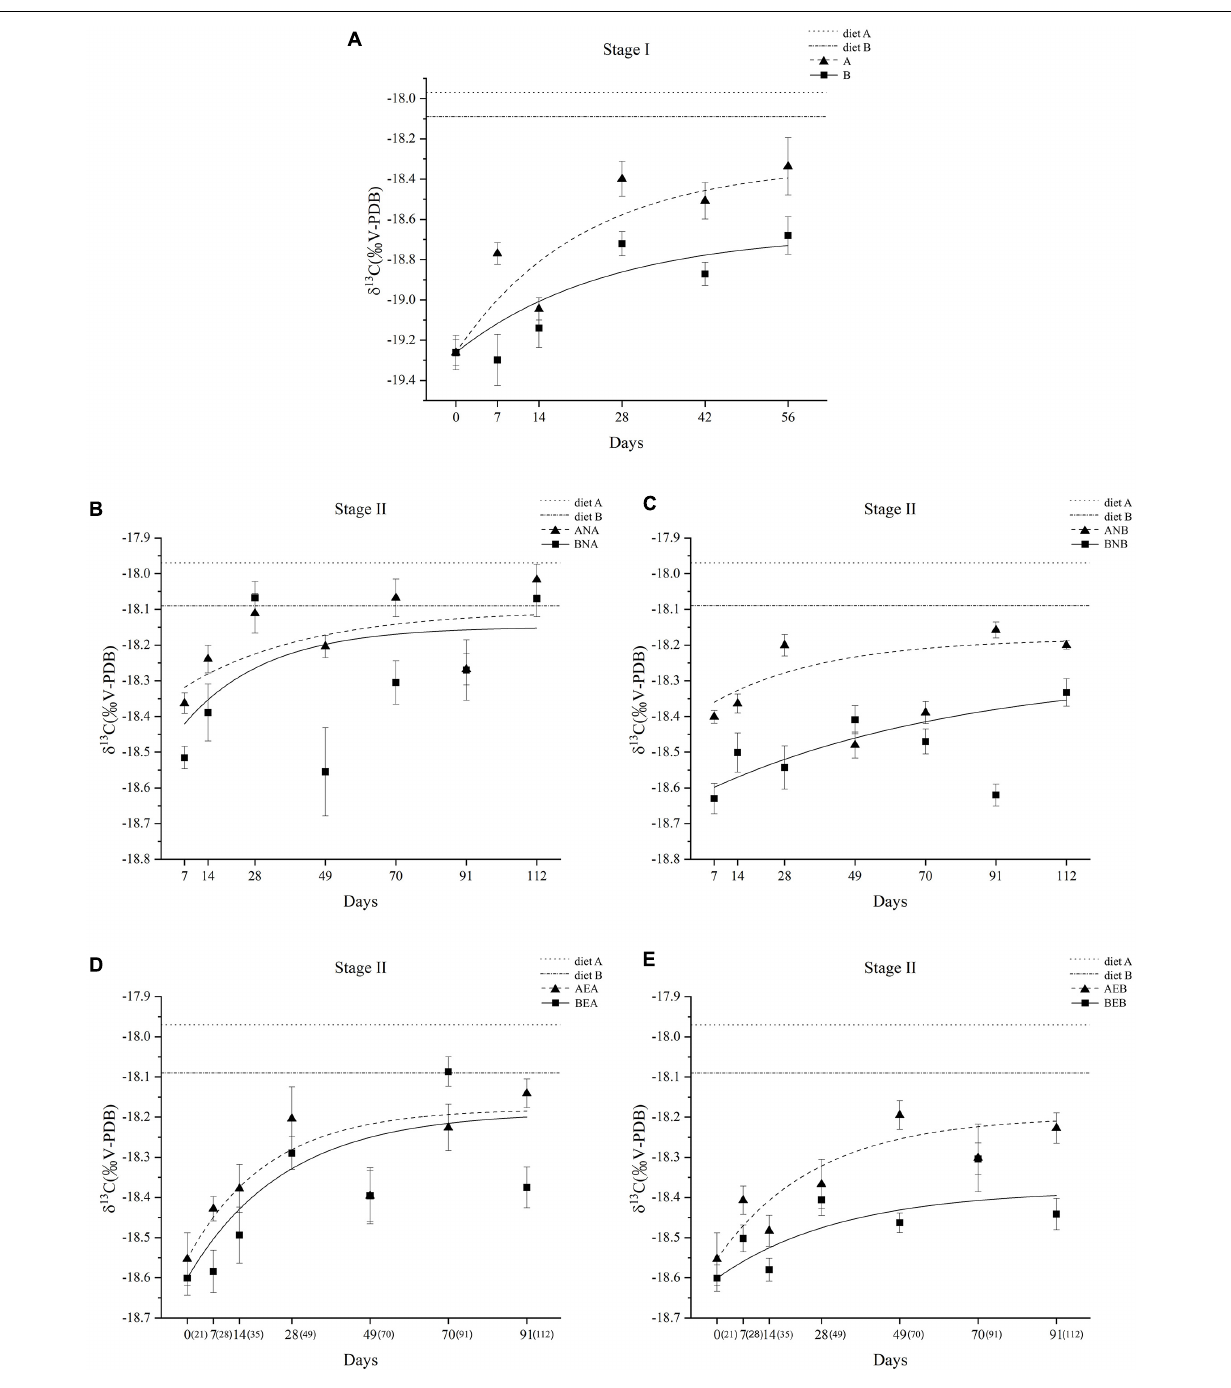
FIGURE 4 | Changes in observed δ 13 C values of body walls of A. japonicus in stage I (A) Changes in observed δ 13 C values of body walls of A. japonicus in stage II (B-E) . Data are presented as mean ± SD ( n =